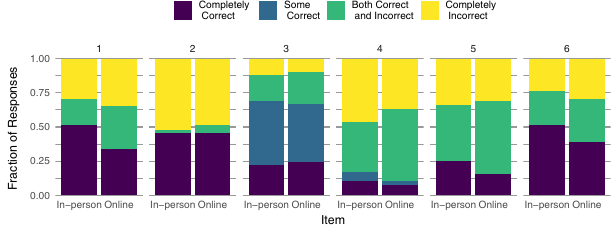
FIG. 7. Fraction of student responses in each category of our four-level scoring scheme for MCMR